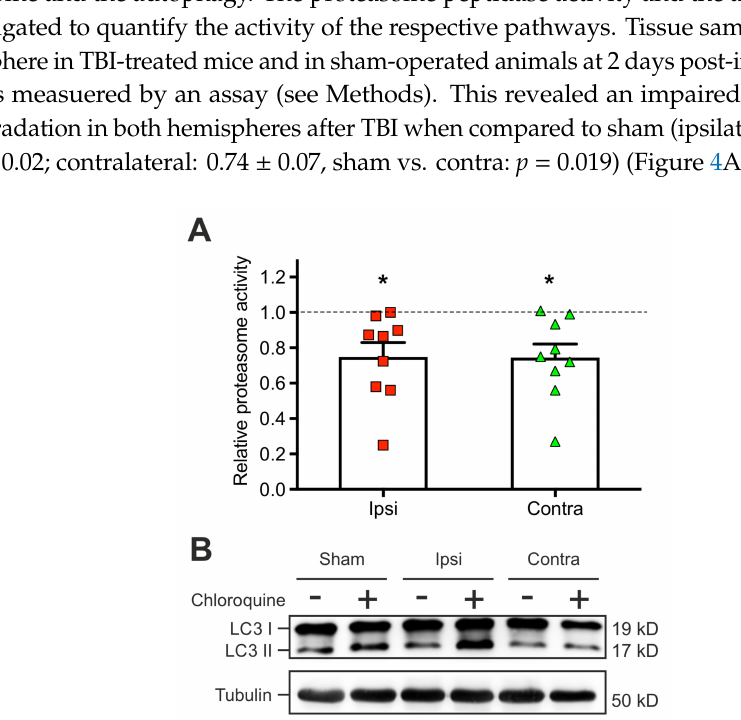
Figure 4. Altered protein degradation systems early after lesion. ( A ) Scatter plots representing the relative proteasome activity (9 mice for each experimental condition) measured in the ipsilateral area of electrophysiological recordings at 2 days post CCI. Data points represent the values for each animal per condition for protein expression levels in the ipsilateral or contralateral hemisphere relative to sham data. Mean and SEM are indicated by the bar plots and error bars. ( B ) Representative Immunoblot of the autophagosomal marker, light chain 3 (LC3) protein, from the cortical area of interest. Both cytosolic (LC3 I) and phosphatidylethanolamine conjugated forms of LC3 (LC3 II) were detected but only LC3 II was quantified in ( B ) after normalization to the housekeeping protein Tubulin. Note the impaired proteasome activity, while autophagy is increased compared to sham animals at the same time suggesting a shift in protein degradation systems. One-way ANOVA and D’Agostino and Pearson normality tests disclosed significant di ff erences of proteasome activity in the ipsi- and contralateral hemisphere, levels of significance are indicated as *: p <